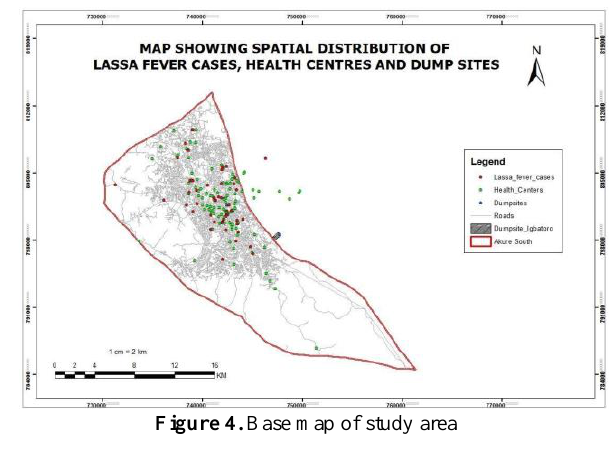
Figure 4. Base map of study